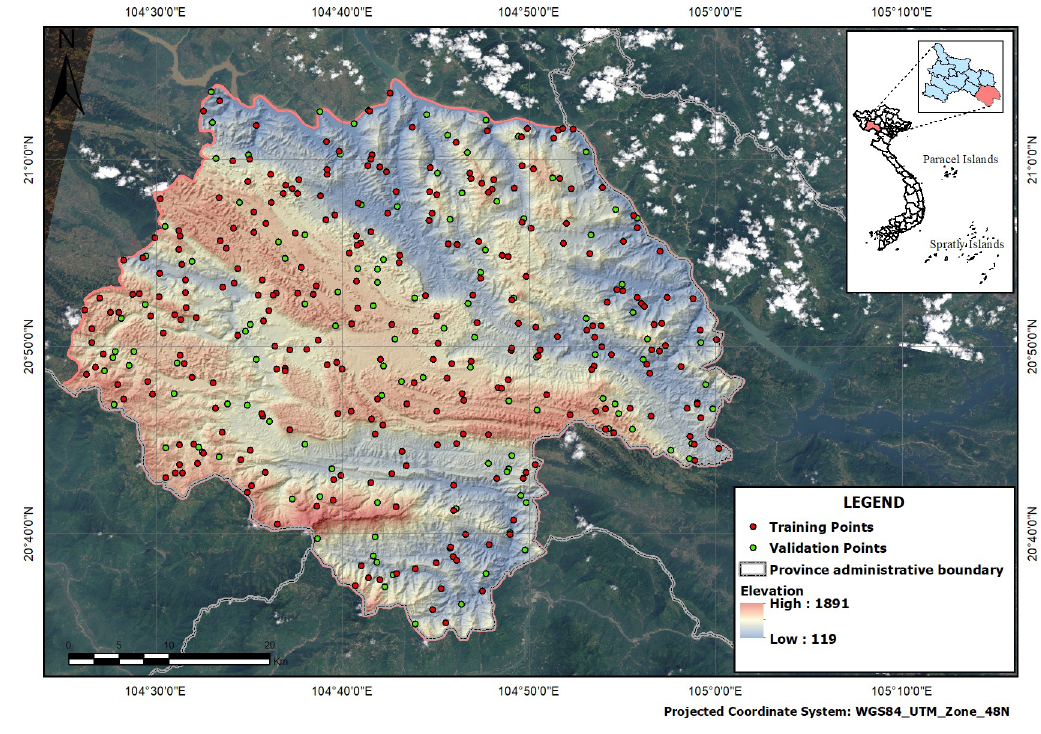
Fig 1. Location of study